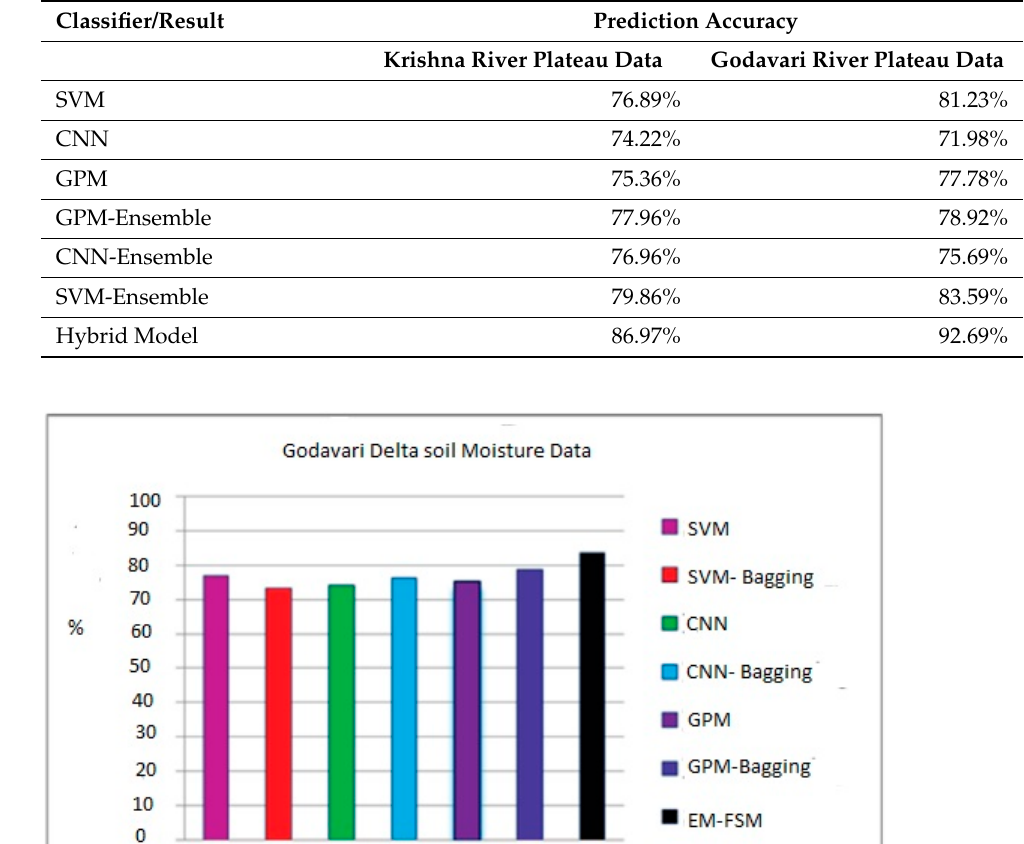
Figure 15. Prediction accuracy of di ff erent classi fi ers.